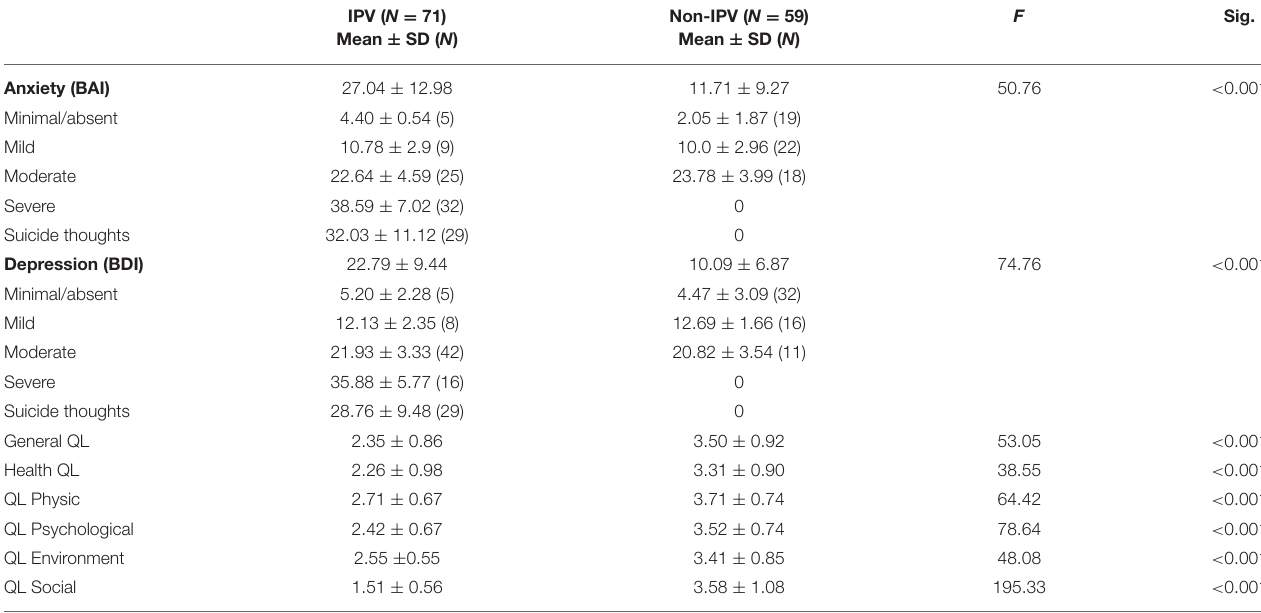
TABLE 2 | Descriptive statistics for anxiety, depression, and quality of life applied to the participants (IPV vs. control